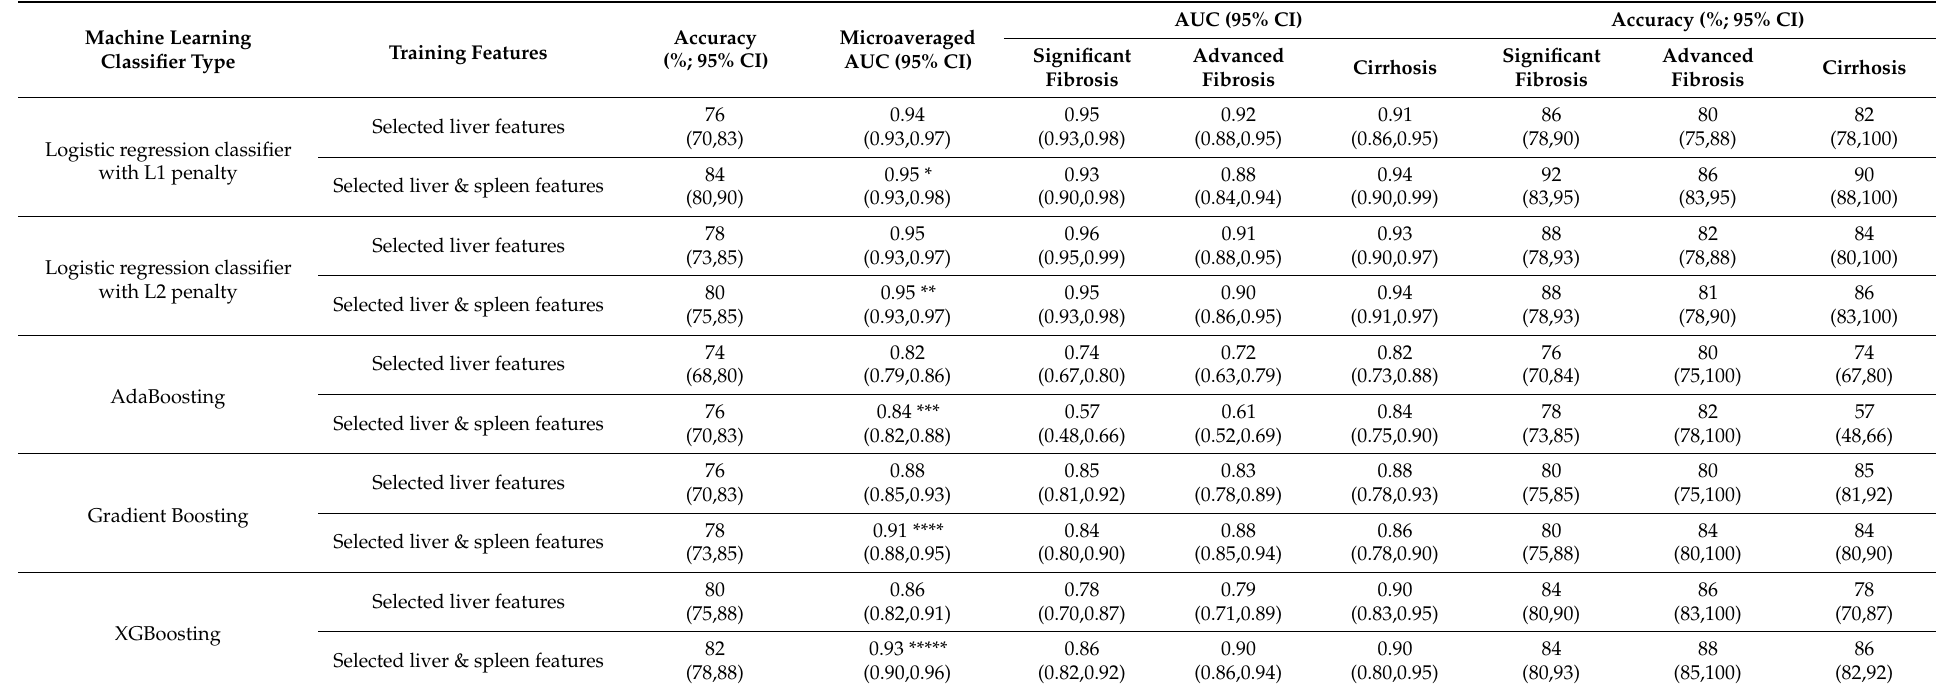
Table 2. Performance of machine learning classifiers for liver fibrosis